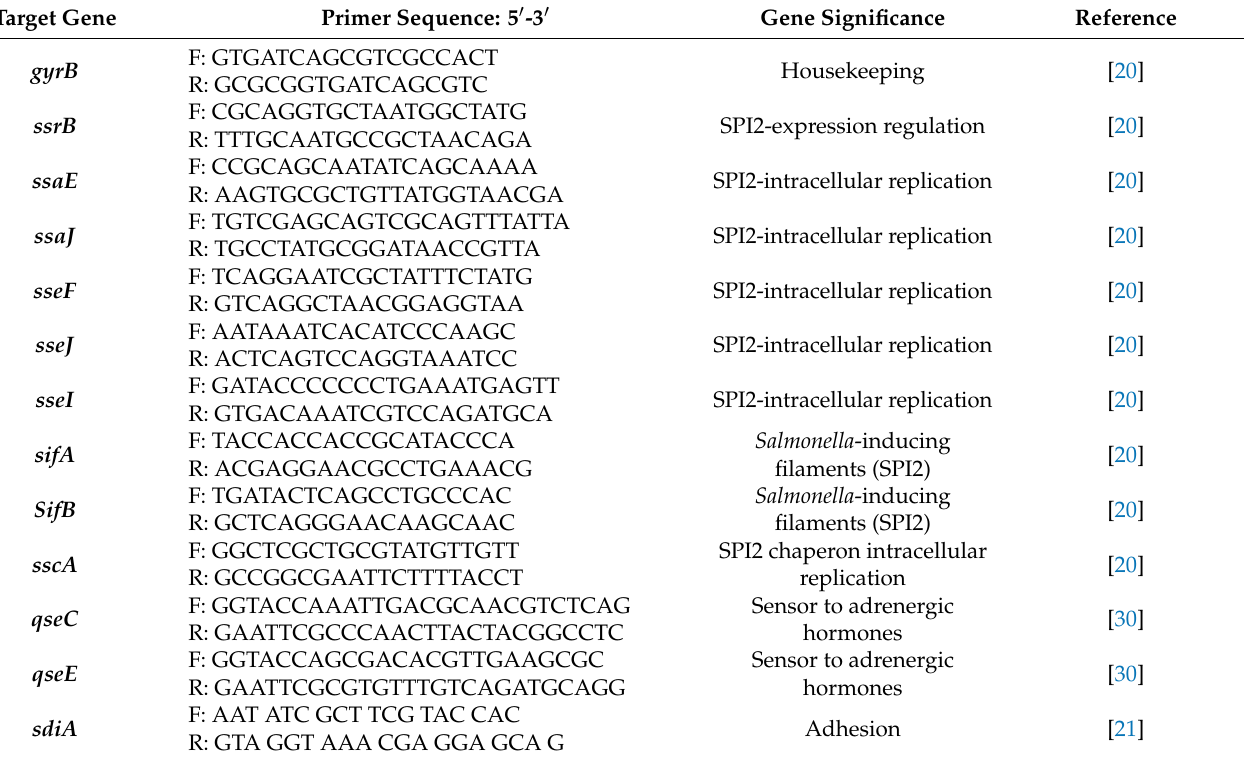
Table 1. The primers used in this study.